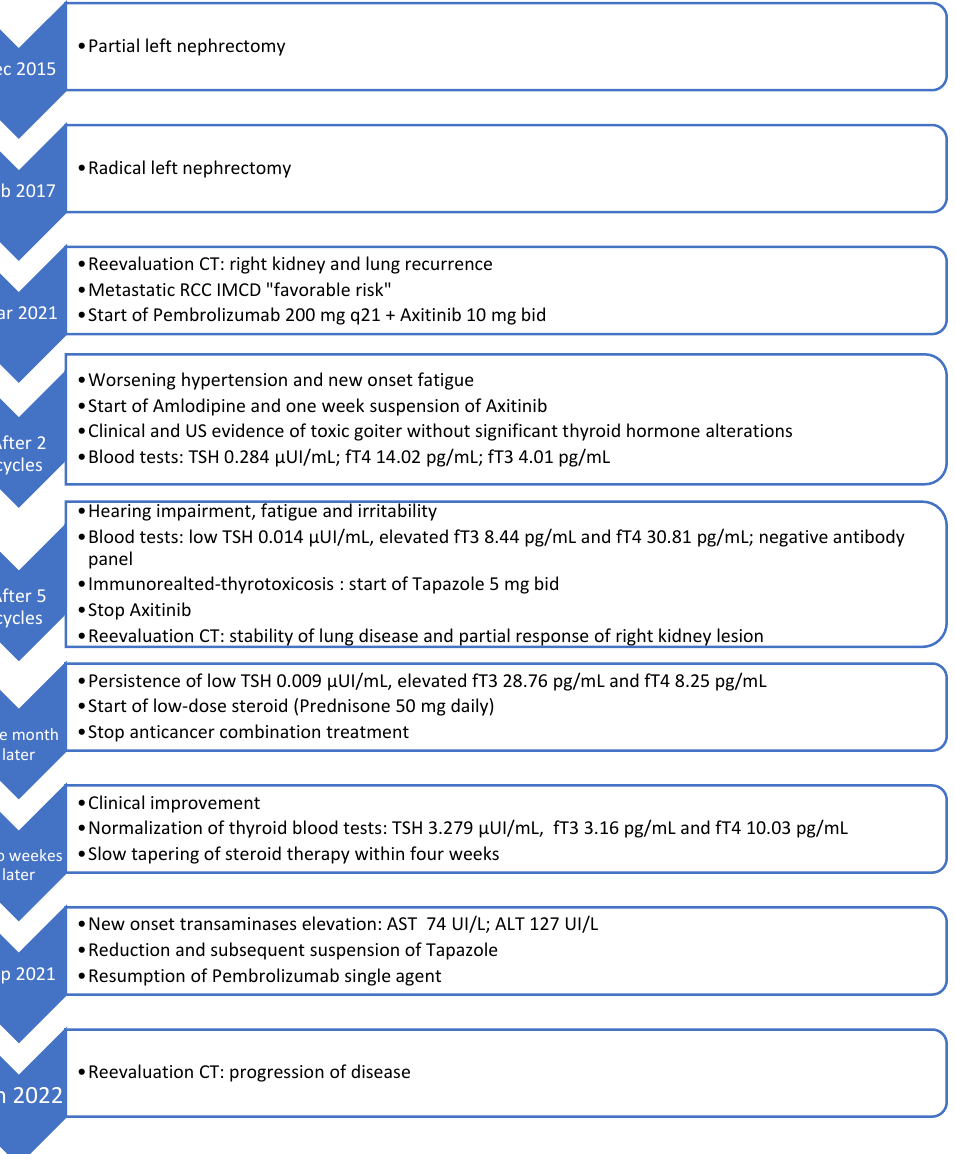
Figure 4. Immunotherapy ‐ related thyroiditis on neck US examination. The thyroid gland is enlarged and swollen; uneven tissue pattern and nodular areas of phlogistic infiltrate are visible.